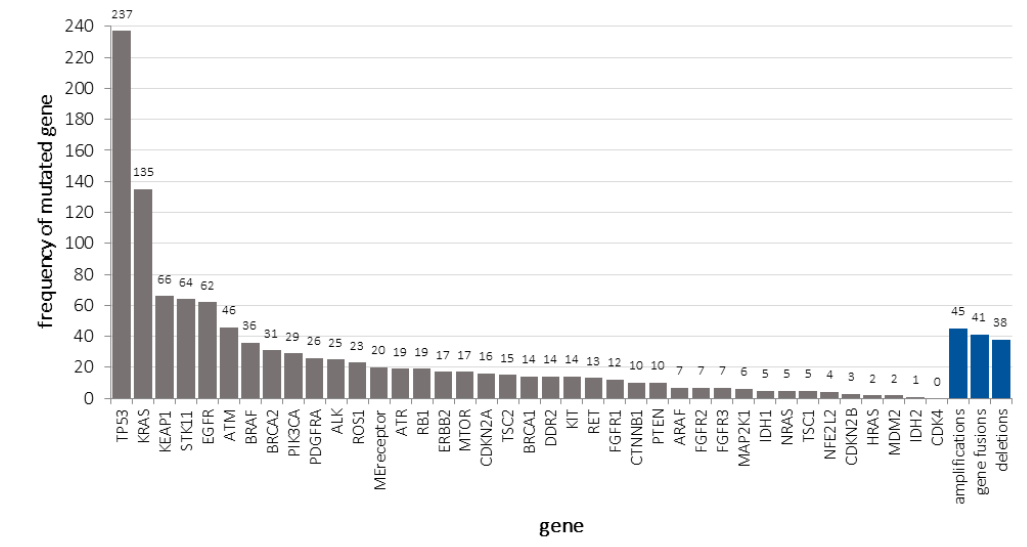
Figure 4. Number of tumors carrying non-synonymous gene mutations in descending order of frequency (grey), including gene amplifications, fusions, and deletions